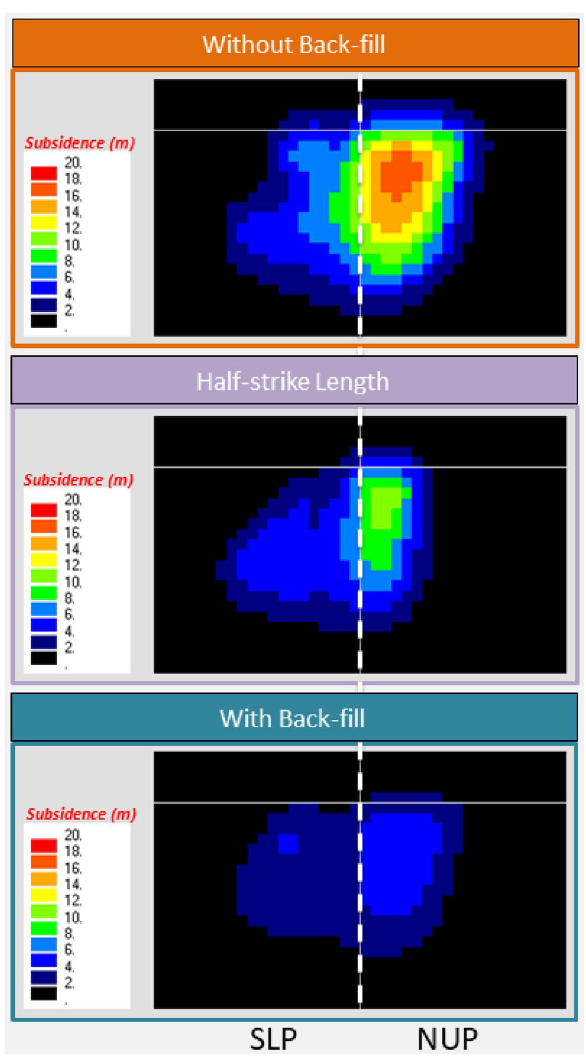
Figure 11. Future subsidence (m) due to total extraction of 30 m coal seam. (ev ver5.01. http:// fubuki. g1. xrea. com/ rml/ fujii/ ev/ ev.